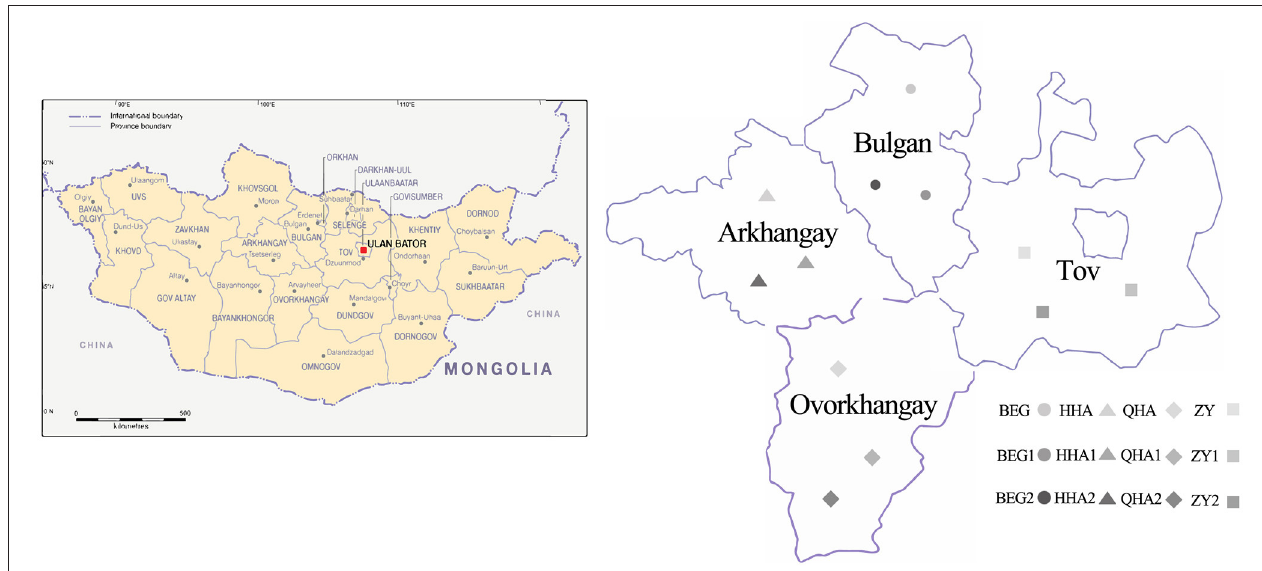
FIGURE 1 | Distribution of 12 Hurunge samples in